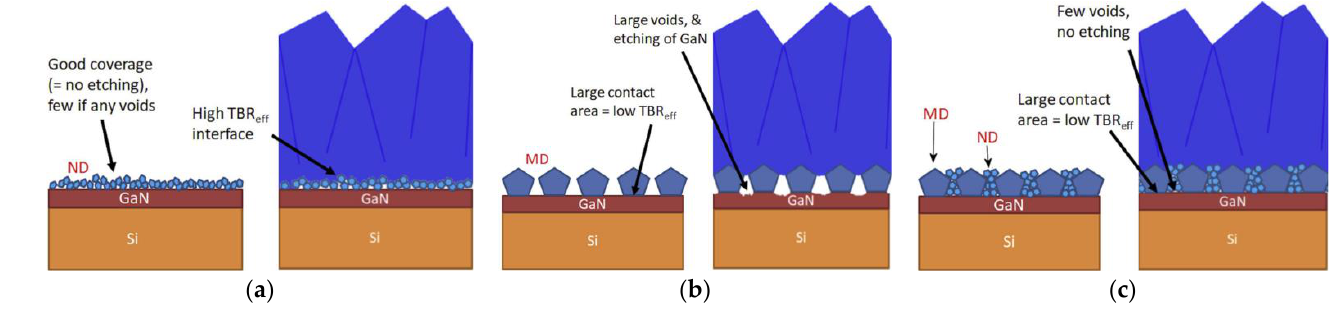
Figure 24. Rationale behind the two-step seeding: seeding with ( a ) ND particles alone, ( b ) diamond microparticles alone, and ( c ) diamond microparticles followed by ND (reprinted from Carbon, vol 167, E. J. W. Smith et al., “Mixed-size diamond seeding for low-thermal-barrier growth of CVD diamond onto GaN and AlN”, pp. 620–626 [76], Copyright 2020, with permission from Elsevier).